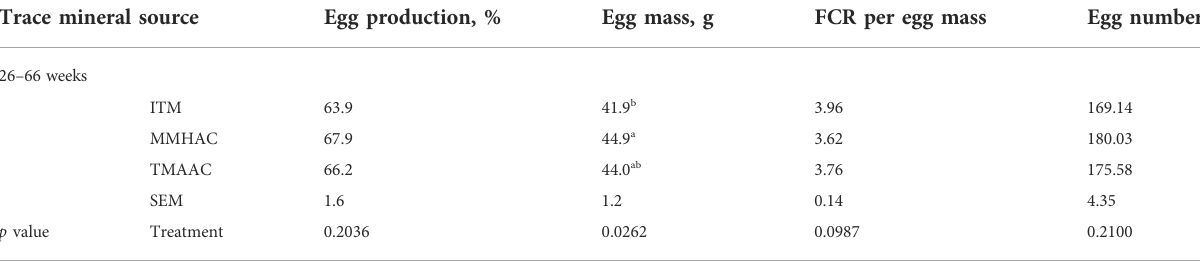
TABLE 6 Effect of feeding supplemental inorganic or organic trace minerals on the performance of broiler breeders (26 – 66 weeks).